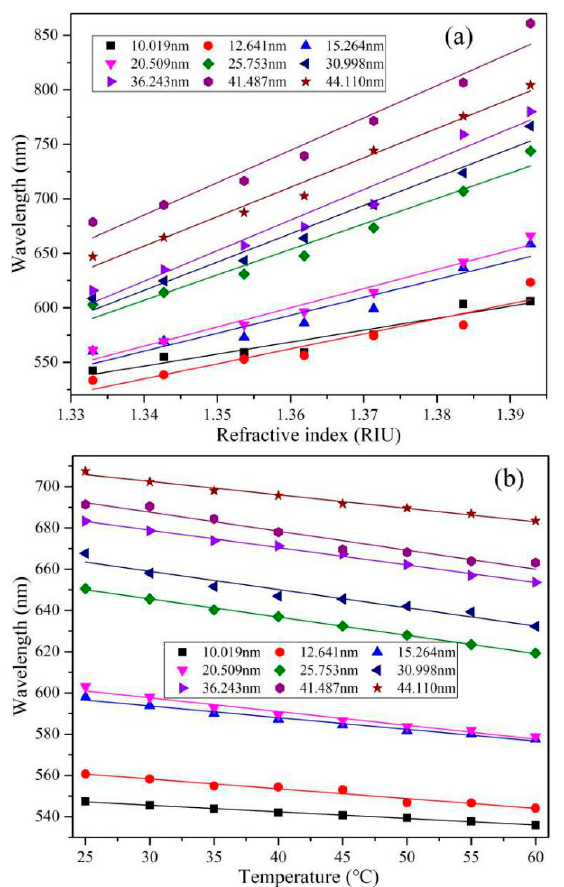
Figure 5. Resonance wavelength as a function of surrounding refractive index ( a ) and ambient temperature ( b ) at different gold film thicknesses.